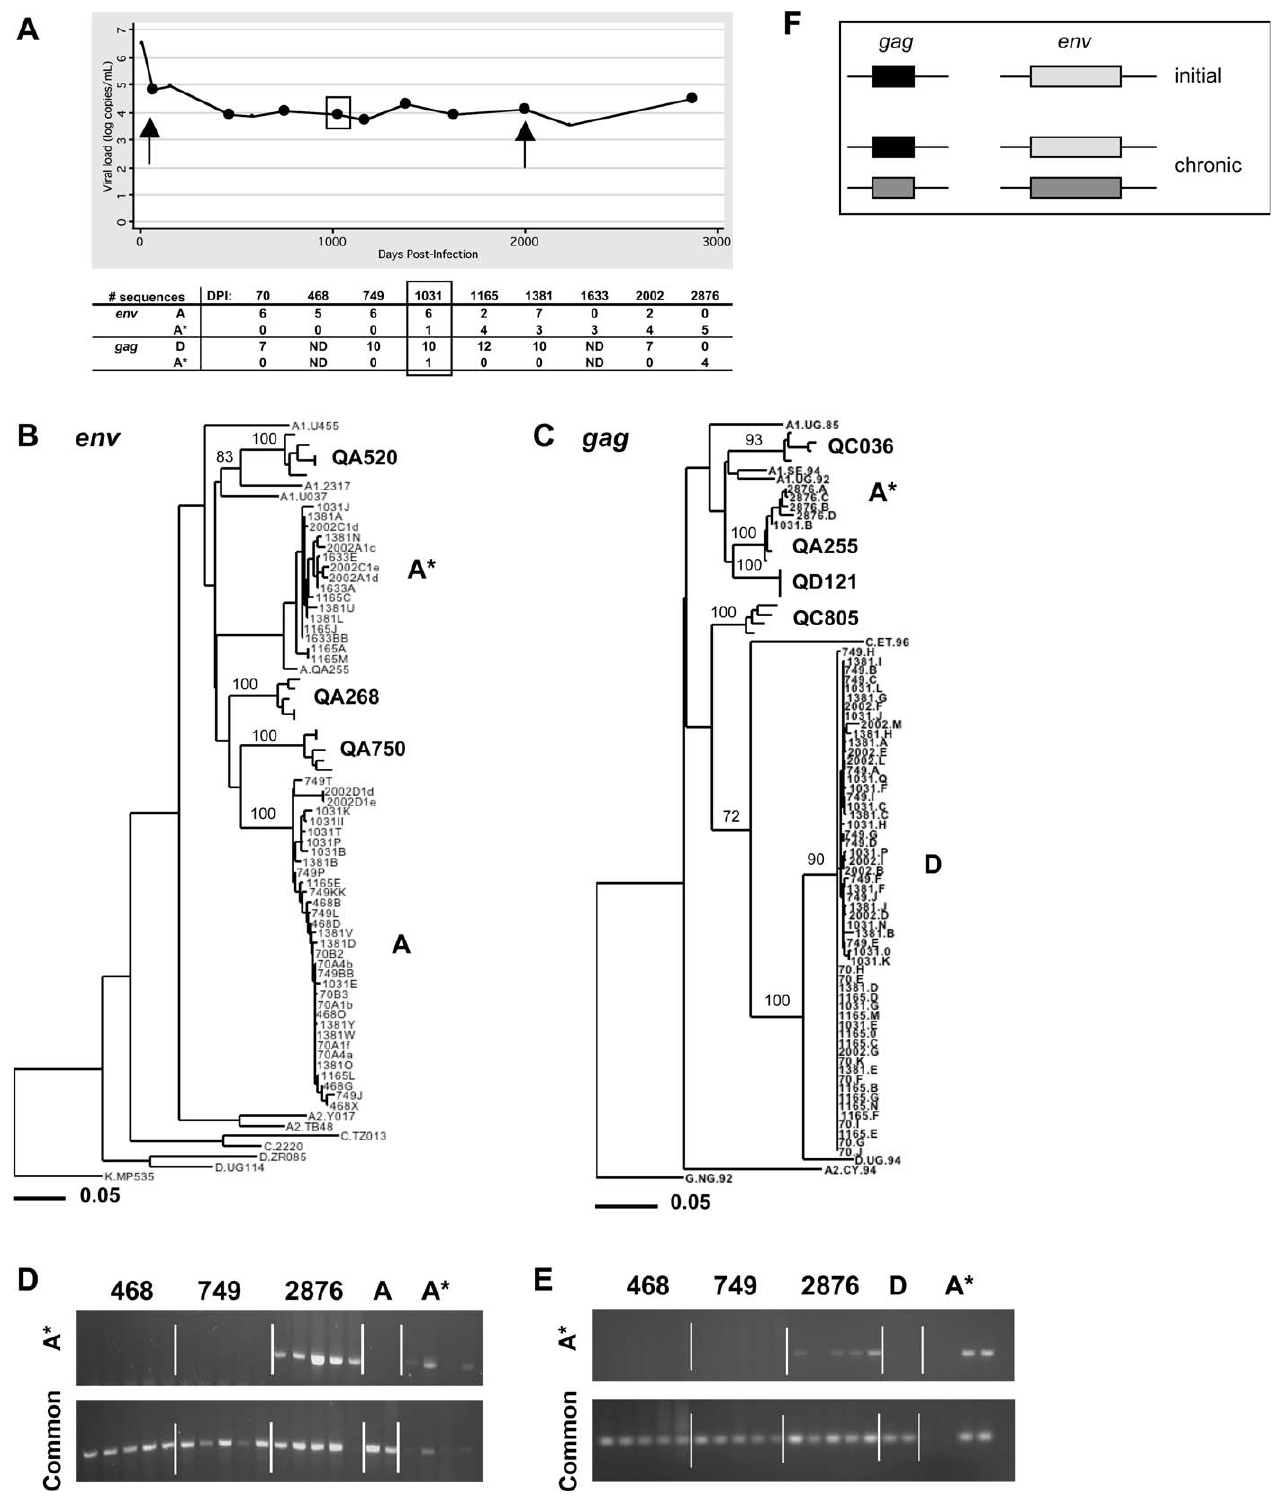
Figure 3. Case 1 (QB726): Intrasubtype Superinfection (Subtype A) between 749 and 1,031 DPI Detected in env and gag (A) Plot of viral load (log RNA copies/mL plasma) versus DPI. Sequences were obtained by single-copy PCR from time points marked by circles. Arrows indicate the initial and chronic time points used in the analysis in Figure 1, and the box indicates the first time point at which the superinfecting strain was detected. The number of sequences of each strain at each time point is indicated in a table below the graph. ND, not done. (B) Maximum-likelihood tree of env sequences from all time points. Sequence names from QB726 are comprised of the sample DPI and a unique identifier. The cluster of strain A contains sequences from all time points except 1,633 and 2,876 DPI. The cluster of strain A* contains sequences from 1,031, 1,165, 1,381, and 2,002 DPI. Sequences from three other individuals (QA520, QA268, and QA750), as well as subtype reference sequences from the LANL database, are also included. Bootstrap values greater than 70% are shown. (C) Maximum-likelihood tree of gag sequences from all time points. Sequence names from QB726 are comprised of the sample DPI and a unique PLoS Pathogens |